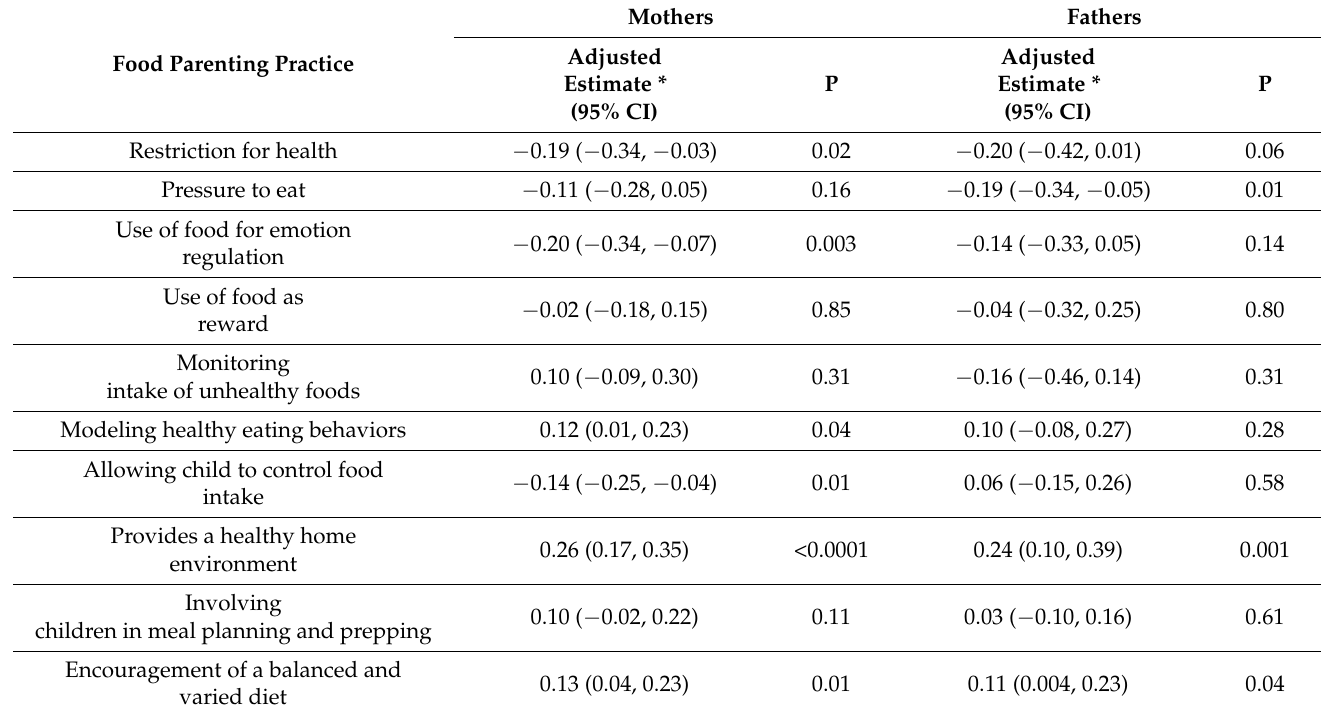
Table 3. Results of linear regressions using generalized estimating equations of mother and father coparenting quality scores with food parenting practices